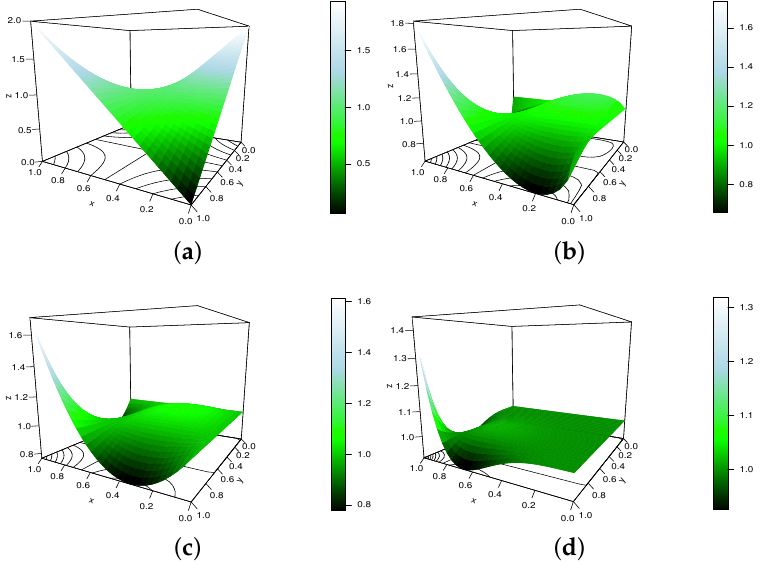
√ γ , and ( a ) γ = 1, ( b ) γ = 1.5,